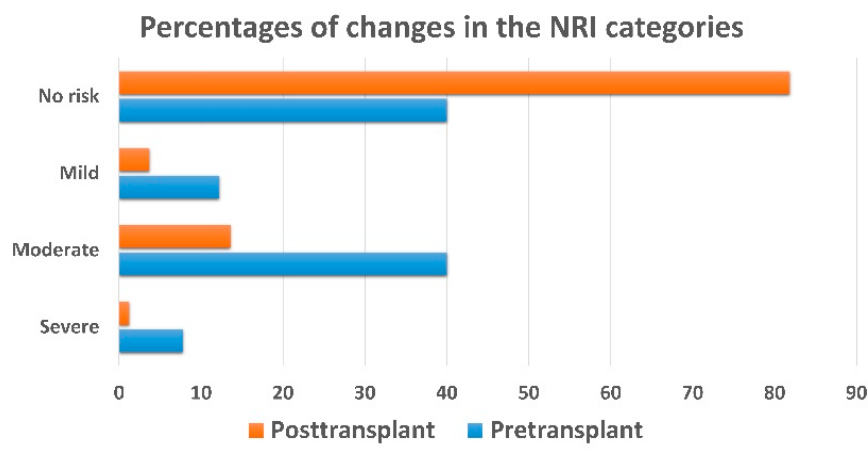
Figure 2. Changes in NRI categories from pre-transplant to 1-year post-transplant.